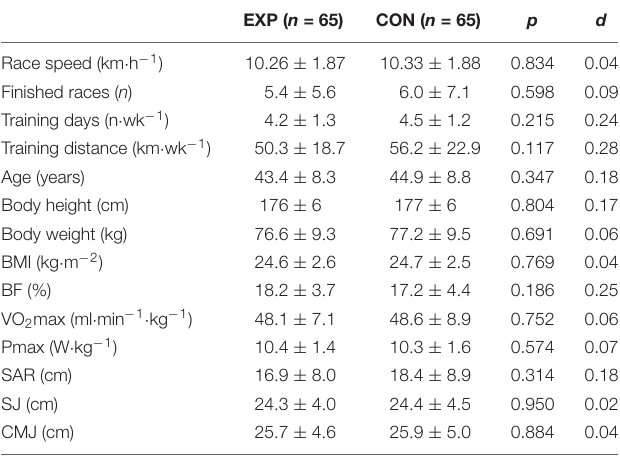
TABLE 3 | Model summary of stepwise regression in the experimental group ( n = 65).